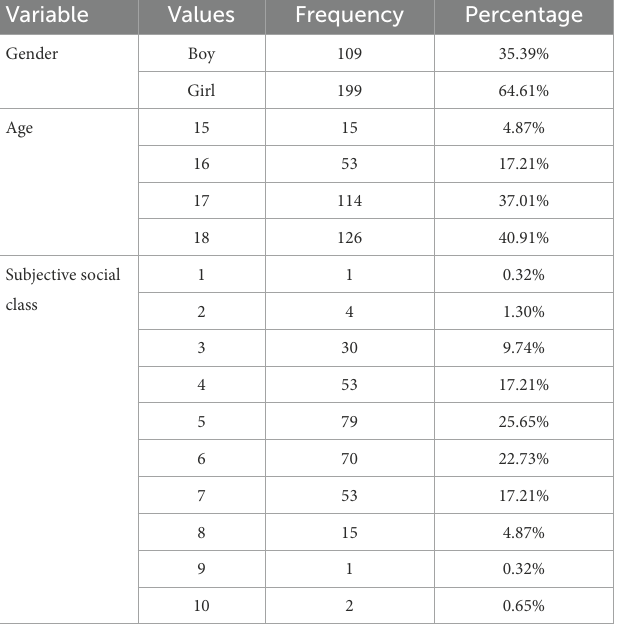
TABLE 1 Demographic